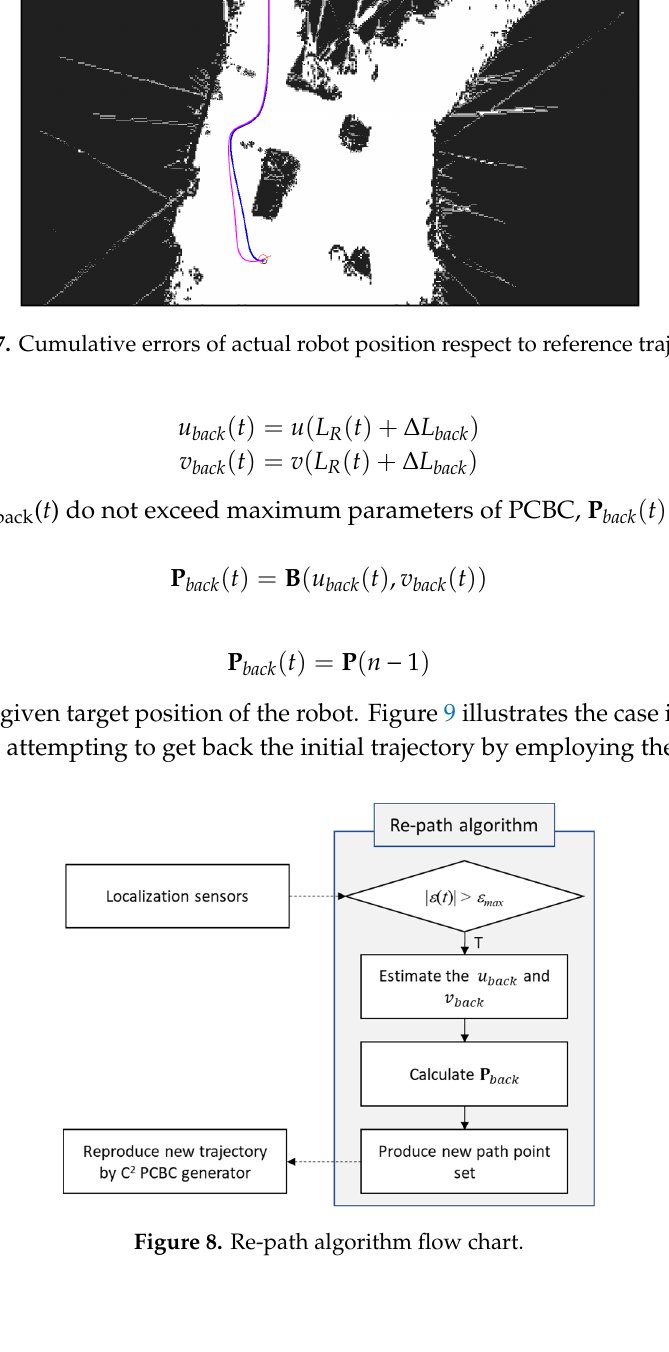
Figure 9. ( a ) Robot moves to the position where curvature is large enough, and deviates from desired trajectory; ( b ) After robot deviates from the trajectory, robot will create a subtrajectory to the back point, ( c ) The robot continues to fail to meet the acceleration condition caused by large curvature of the first created subtrajectory, the robot repeatedly create subtrajectory until it returns to original path. 7. Obstacle-avoidance 7.1. Detect Collision by Using Gradient Descent and Context Analysis Based Obstacle-avoidance Scheme For convenience, we assume that the robot sensors have already detected moving obstacles when it moves over the scanning area. The information from sensors can obtain which includes a radius of the circular boundary of obstacle body, position of center of boundary and constant linear velocity. It has two distinct cases when the robot detects the object: - Obstacle passes over the dead zone. -